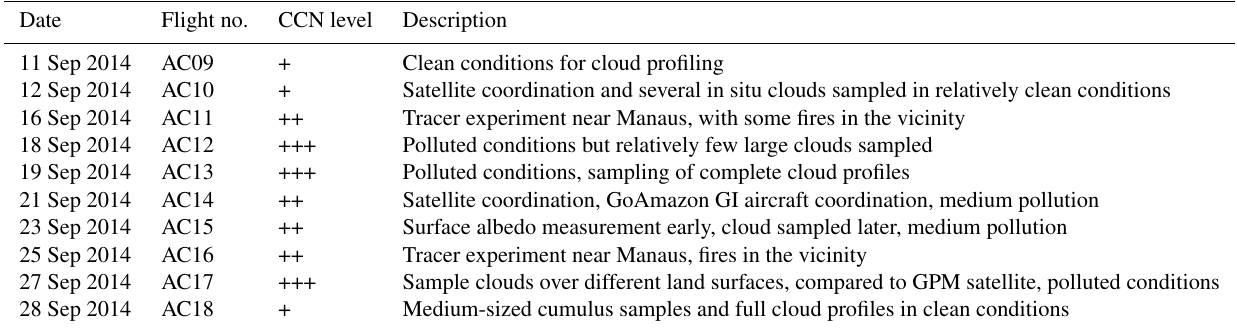
Table 1. Dates of flights conducted during the ACRIDICON-CHUVA campaign, with basic information about each flight compiled from Wendisch et al. (2016) and the campaign blog (https://acridicon-chuva.weebly.com/, last access: 10 July 2018). CCN levels during each research flight are binned into low (“+”), medium (“++”), and high